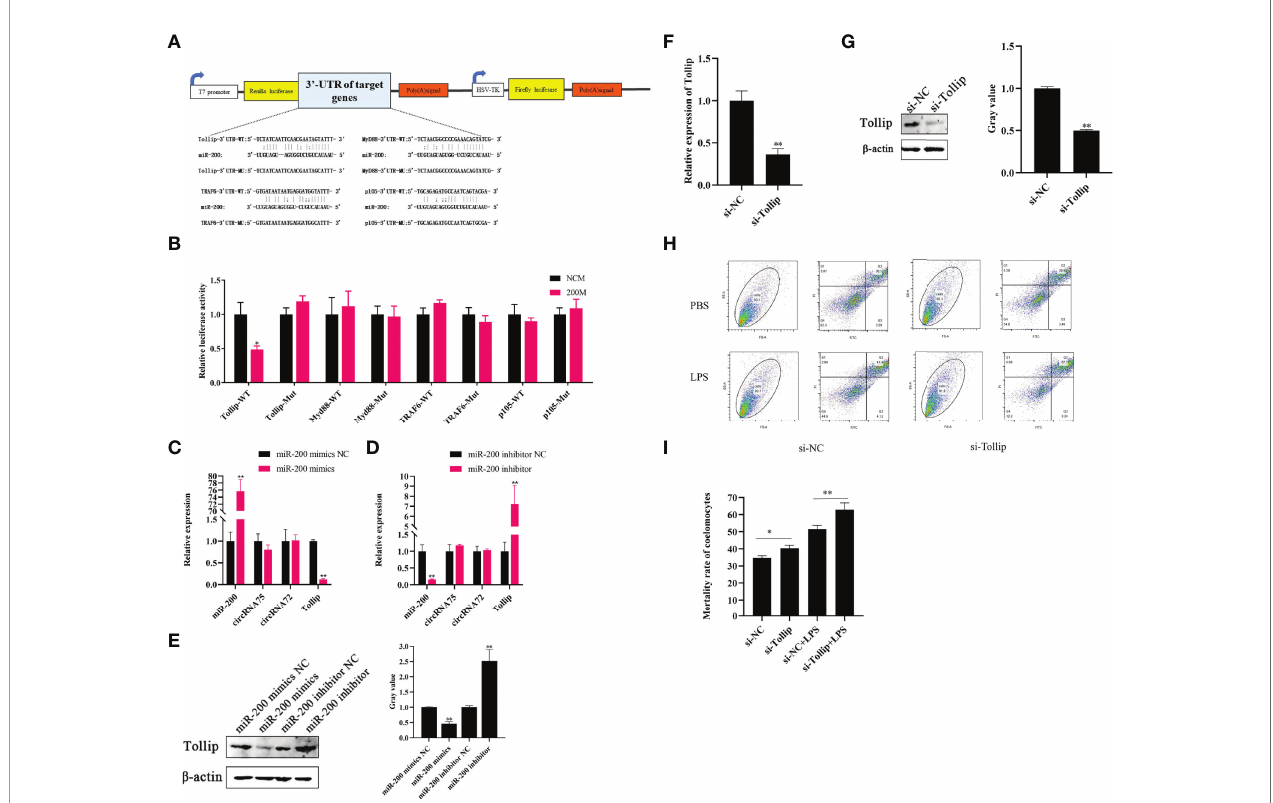
FIGURE 3 | Tollip is a direct target of miR-200 to attenuate LPS-induced coelomocyte apoptosis. (A) Schematic illustration of target genes and Mut luciferase reporter vectors. (B) Relative luciferase activities were measured in EPC cells after transfection with WT or Mut and a miR-200 mimic or miR-NC. (C, D) qRT-PCR was applied to detect the regulation of miR-200 mimics and inhibitors on the mRNA levels of Tollip, circRNA75, and circRNA72. (E) Western blot and gray value analysis were used to detect the regulation of miR-200 mimics and inhibitors on the protein levels of Tollip. (F) qRT-PCR detected the mRNA level of Tollip after the transfection of si-Tollip. (G) Western blot and gray value analyses detected the protein level of Tollip after the transfection of si-Tollip. (H) Coelomocyte apoptosis assay after Tollip knockdown in vitro . (I) Statistical analysis of apoptosis rate after Tollip knockdown. * p < 0.05 and ** p <